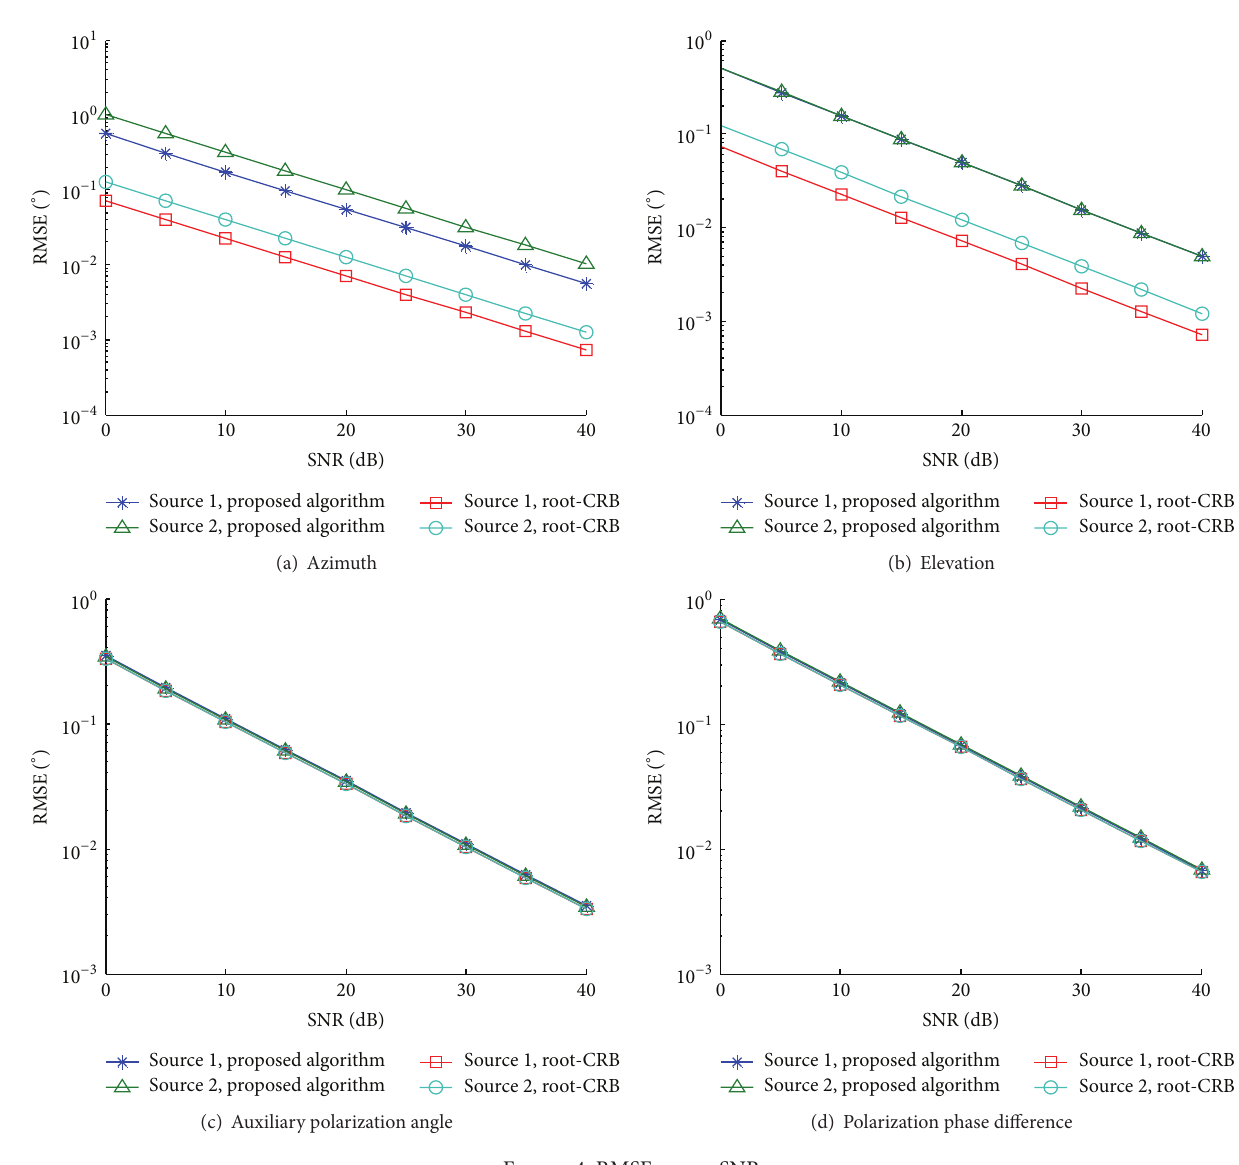
Figure 4: RMSE versus